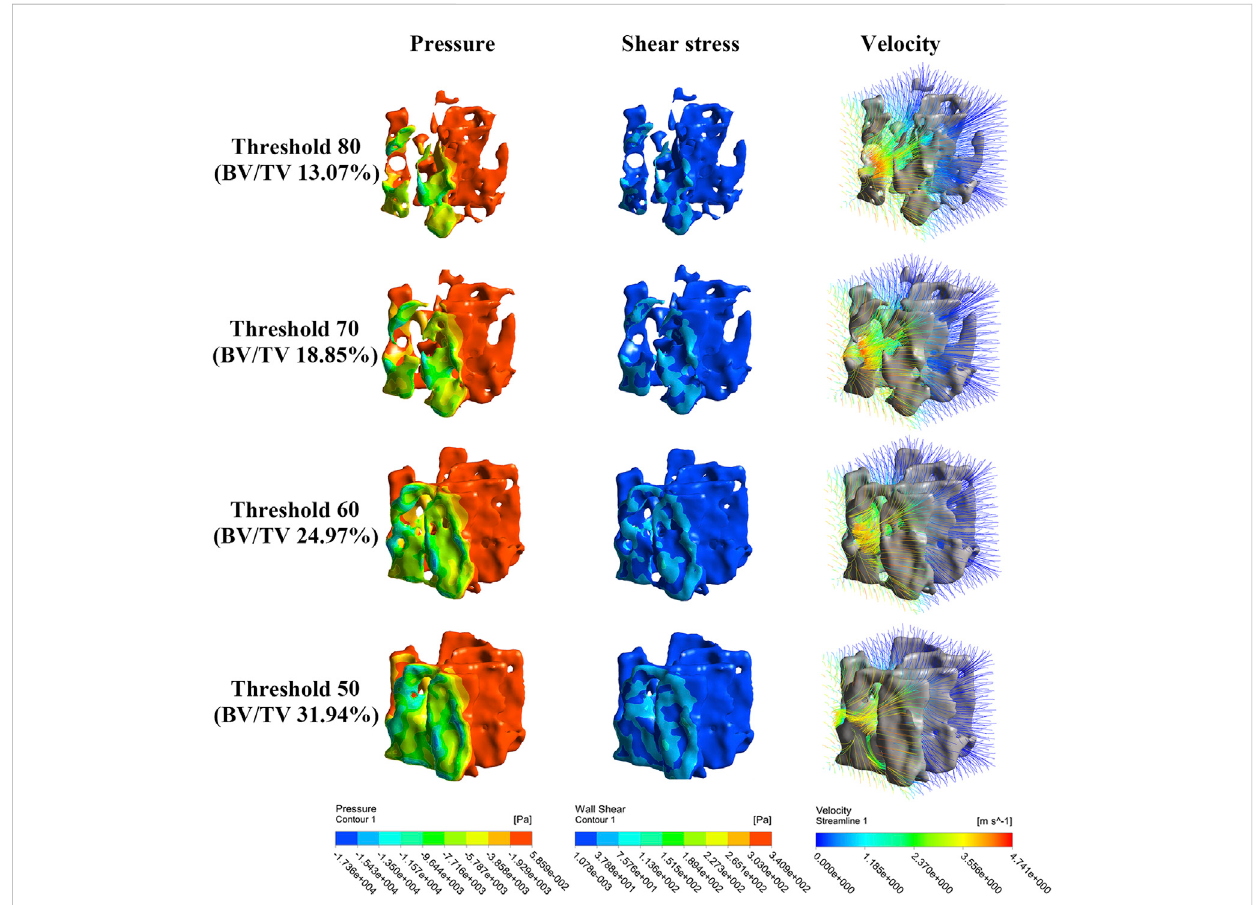
FIGURE 6 Nephogram of dependence variables result from simulated bone remodeling (take NP along the X-axis for clarity). The pressure, shear stress and morrow fl ow velocity concentrate near to the NP source.